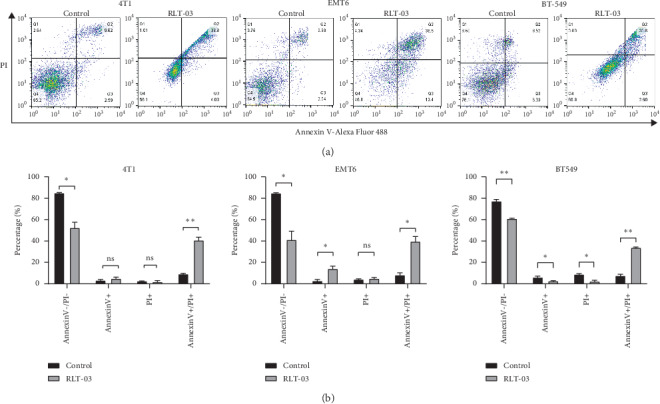
Flow cytometry assay results of RLT-03 induced breast cancer cell apoptosis. RLT-03 induced an increase in the proportion of Annexin V-positive and Annexin V/PI-positive 4T1, EMT6, and BT-549 cells, and the IC50 dose of RLT-03 mainly induced late apoptosis (p < 0.05∗).